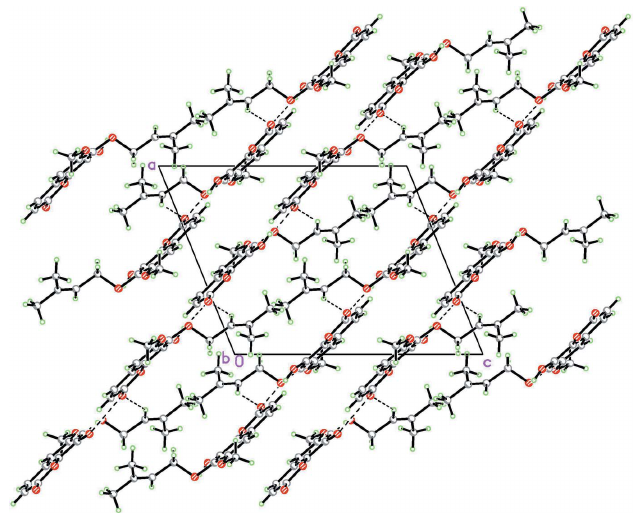
Figure 2 Crystal structure of the title compound in a projection on the (101) plane. Intermolecular hydrogen bonds are shown as dashed lines. The figure shows only the major occupancy component of the disordered 3- methylbut-2-enyloxy substituent at atom C7.